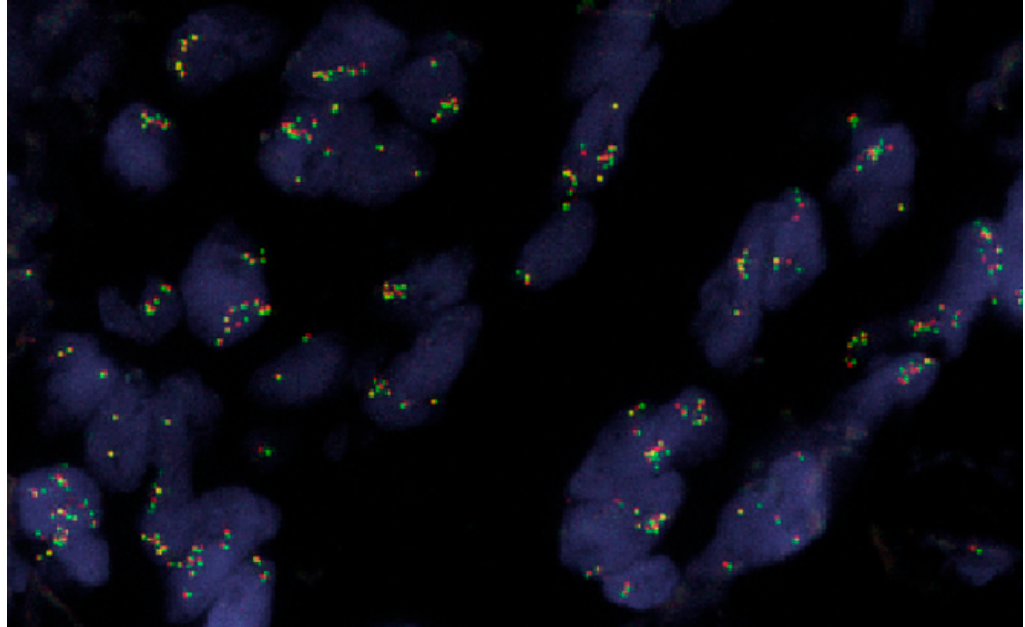
Figure 3. An example of ALK amplification in a lung adenocarcinoma case. The majority of tumor cells showed 6 to 20 copies of ALK gene or cluster ALK signals (60x). showed 6 to 20 copies of ALK gene or cluster ALK signals